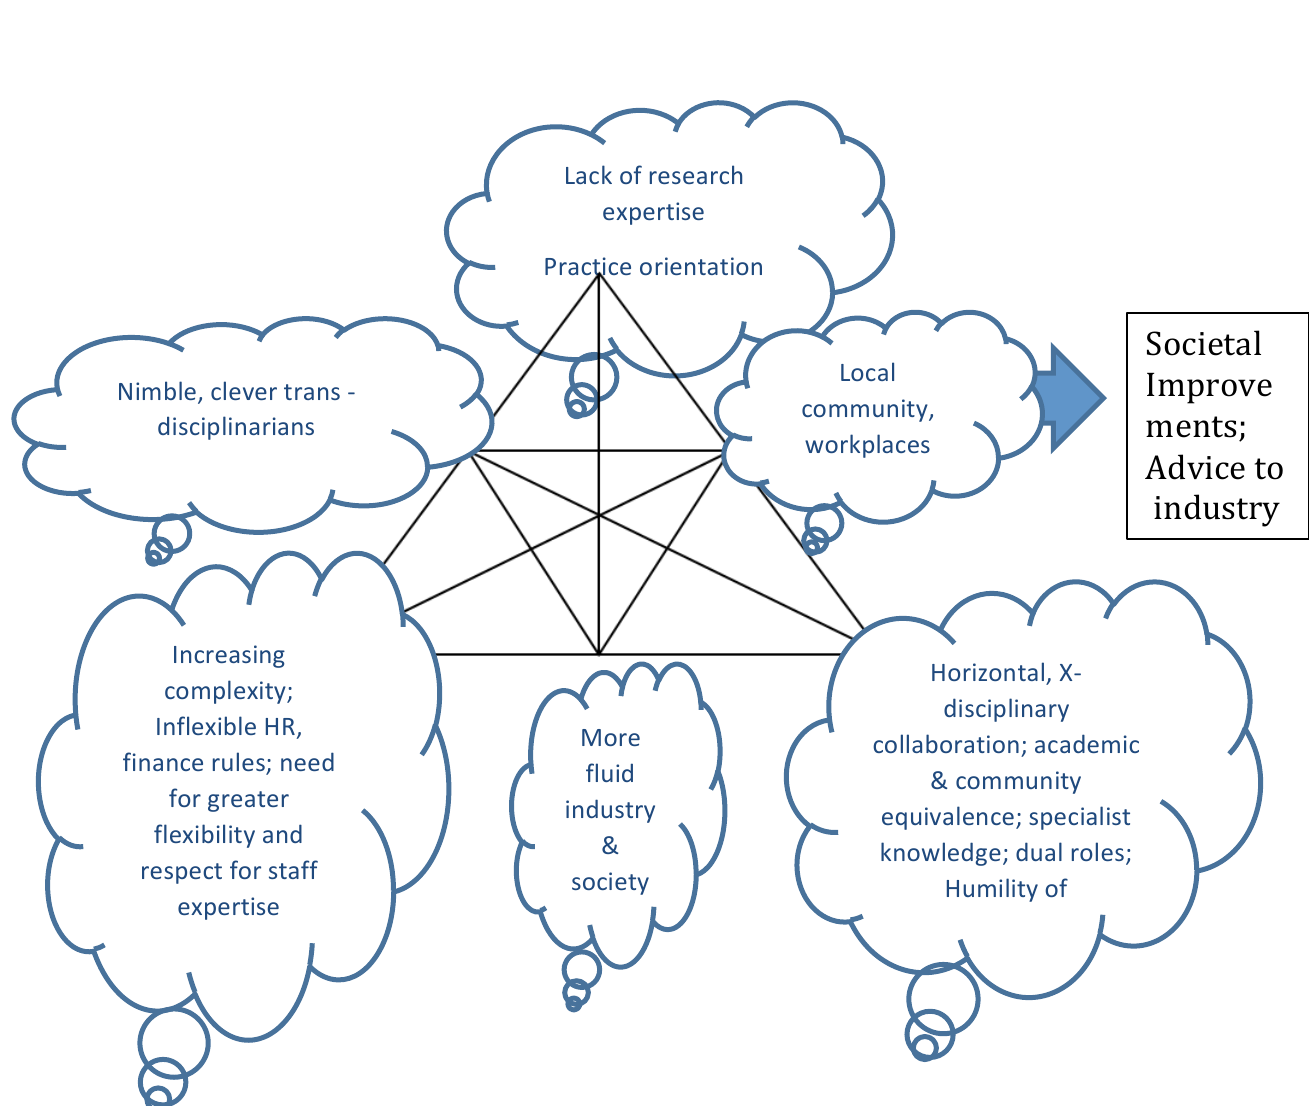
Figure 4: A community vision towards more flexible